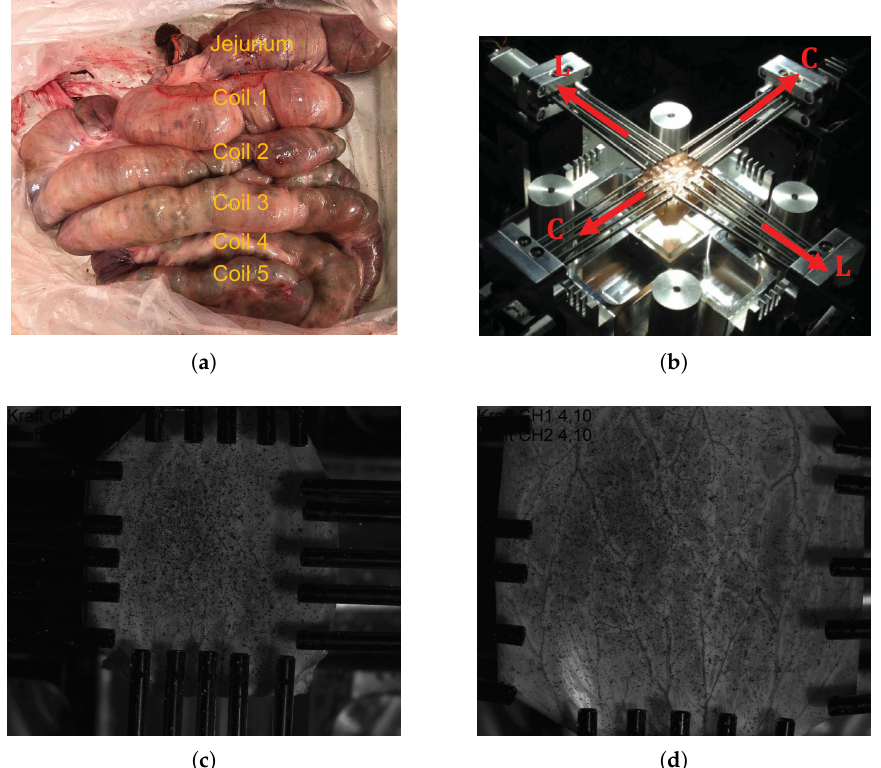
Figure 1. ( a ) Porcine large intestine as an intact organ prior to segmentation showing jejunum and five colon coils; ( b ) biaxial tensile test set up illuminated by the polarized light showing fiber orientations and the device coordinate system, and images of the test specimen in the ( c ) undeformed configuration and ( d ) deformed configuration taken from